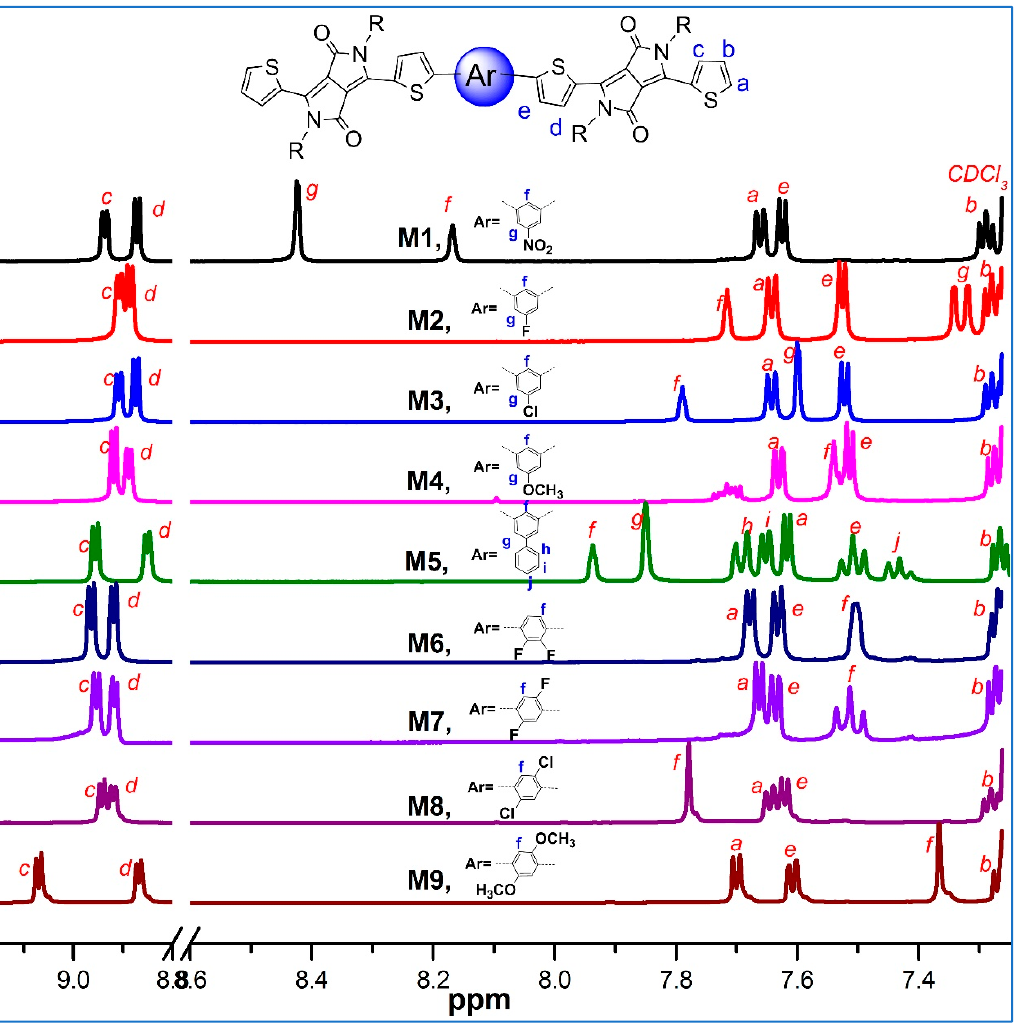
Figure 1. 1 H-NMR spectra for Ms1~9 at 7.28–9.2 ppm.